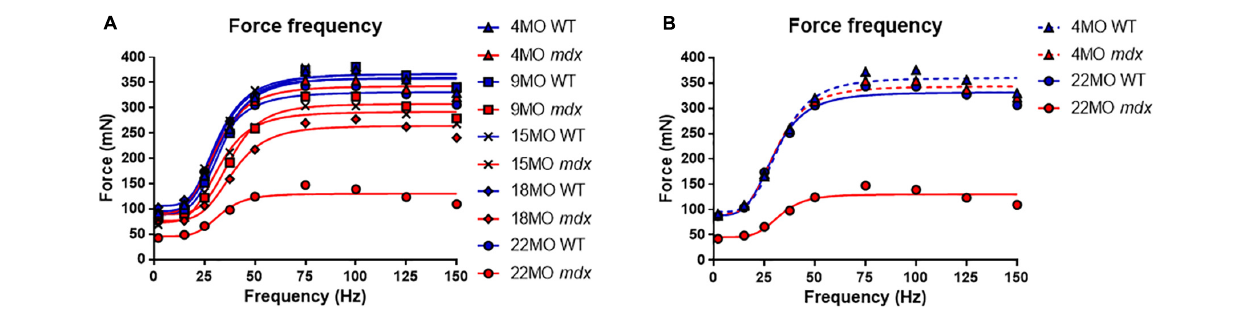
FIGURE 4 | Force frequency curves. (A) Aggregated force frequency curves from EDL muscles to visualize differences between genotype across 4-month ( n = 7 control; n = 7 mdx ), 9-month ( n = 6 control; n = 7 mdx ), 15-month ( n = 7 control; n = 6 mdx ), 18-month ( n = 6 control; n = 7 mdx ), and 22-month ( n = 6 control; n = 7 mdx ) age groups. Muscle absolute force was measured at different stimulation frequencies and a sigmoidal curve (lines) was fitted to the data points (see section “Materials and Methods”), contractile properties were generated from these curves (see Table 1 ). (B) For clarity 4-month and 22-month old age groups have been isolated to highlight the shape and slope of these force frequency curves. Data shown in these curves are mean only, SD was omitted for visual clarity.